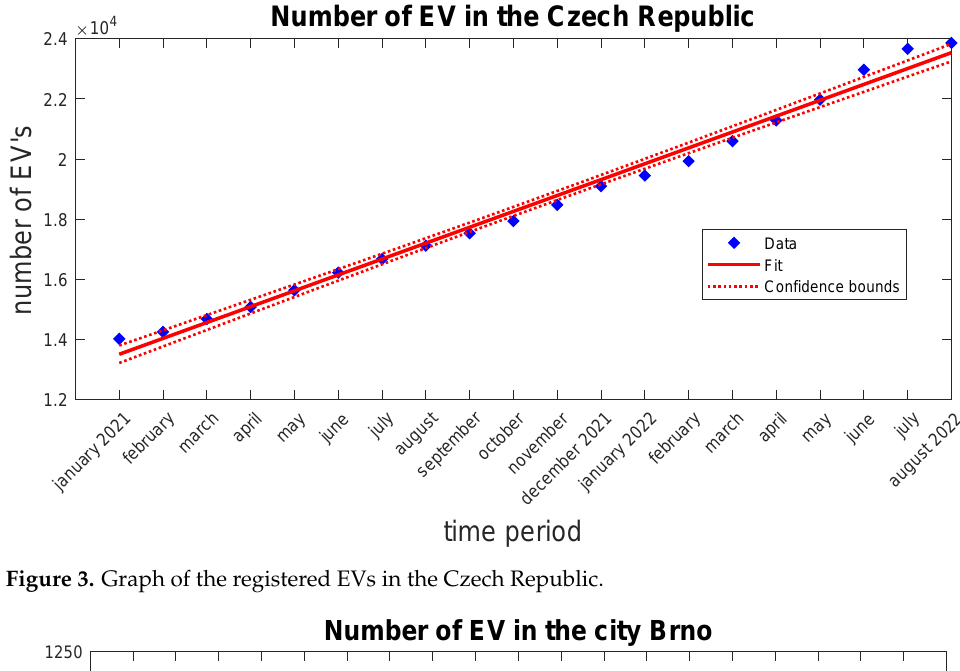
Figure 3. Graph of the registered EVs in the Czech Republic.